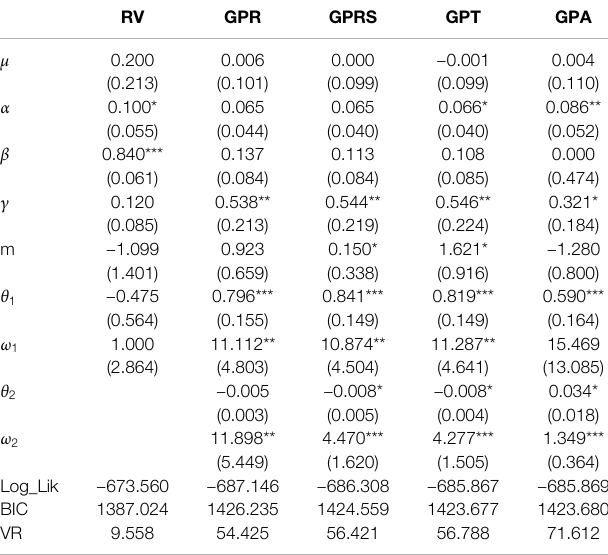
TABLE 2 | Estimation GARCH-MIDAS models with geopolitical